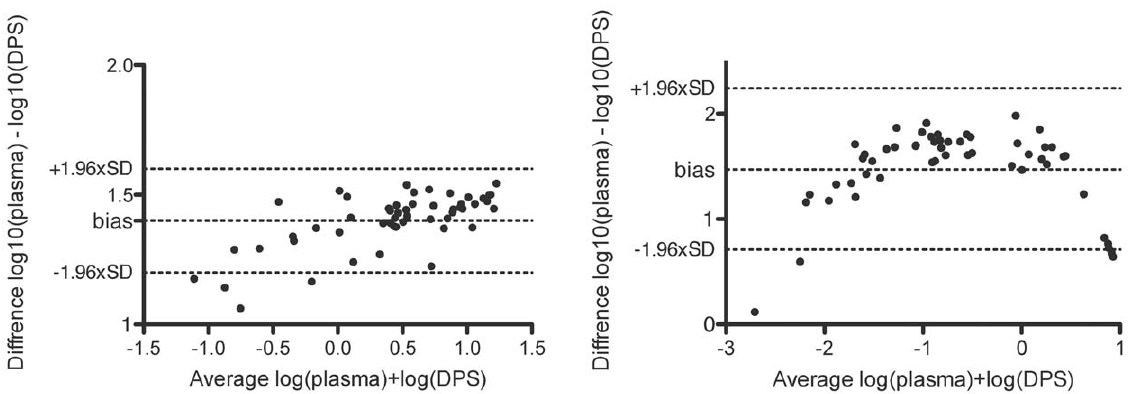
Figure 3. Agreement between IP-10 (A) and IFN- c (B) detected in plasma and DPS samples. IP-10 and IFN- c signals were detected in samples from 18 Quantiferon-TB positive donors; nil, antigen and mitogen samples were corrected for the dilution factor in plasma. Samples were pooled rendering a total of 54 data-points per graph. DPS concentrations were analyzed as ng/2 discs for IP-10 and IU/2 discs for IFN- c signals (DPS) and log transformed to facilitate comparison between high (plasma) and low DPS. Each sample is represented on the graph as the average of the two measurements against the difference. The limits of agreement are specified as the average difference (bias) 6 1.96 standard deviation of the